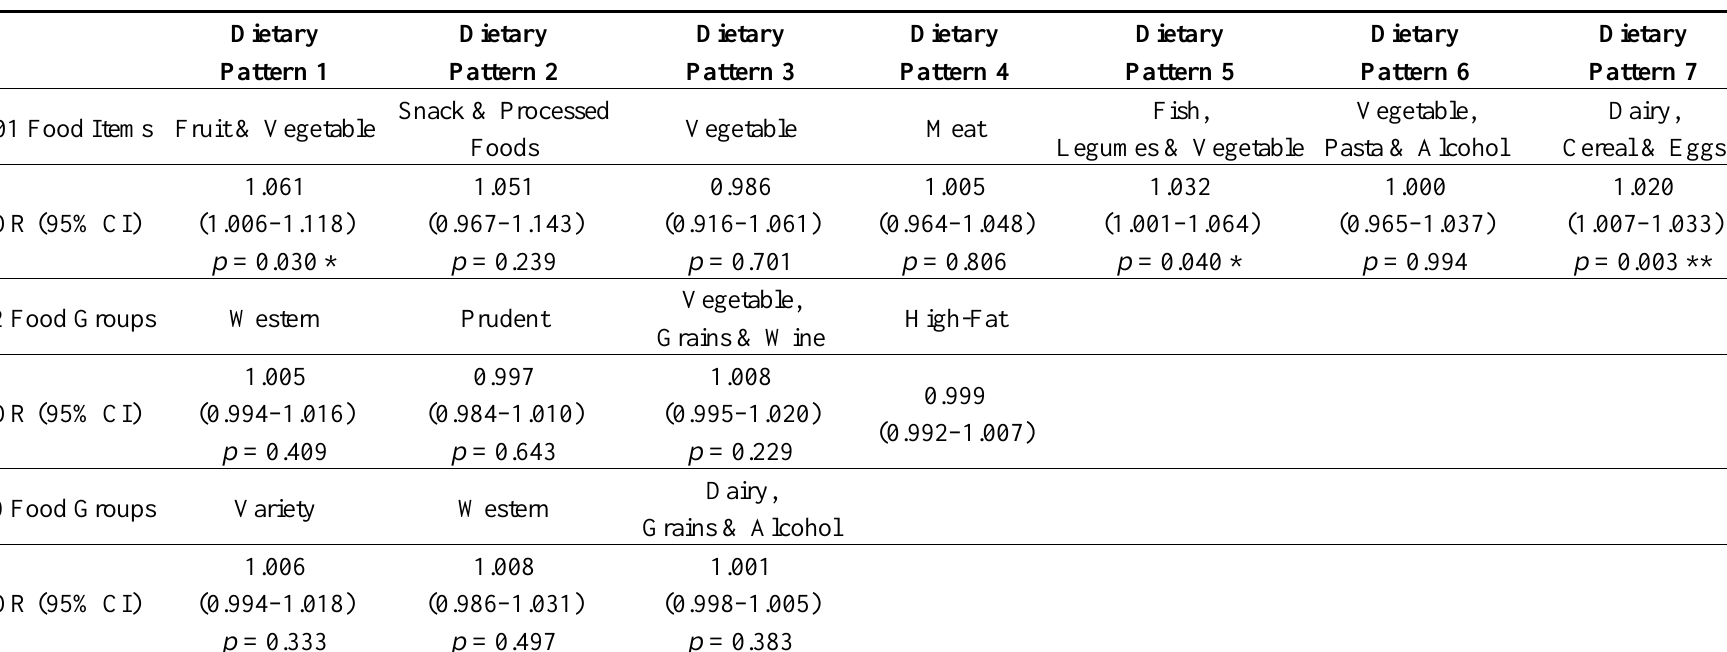
Table 3. Results of logistic regression analyses showing associations between CI at Wave 3 and dietary patterns obtained using 101 food items, 32 food groups and 20 food groups at Wave 1 (odds ratios with 95% confidence intervals shown in